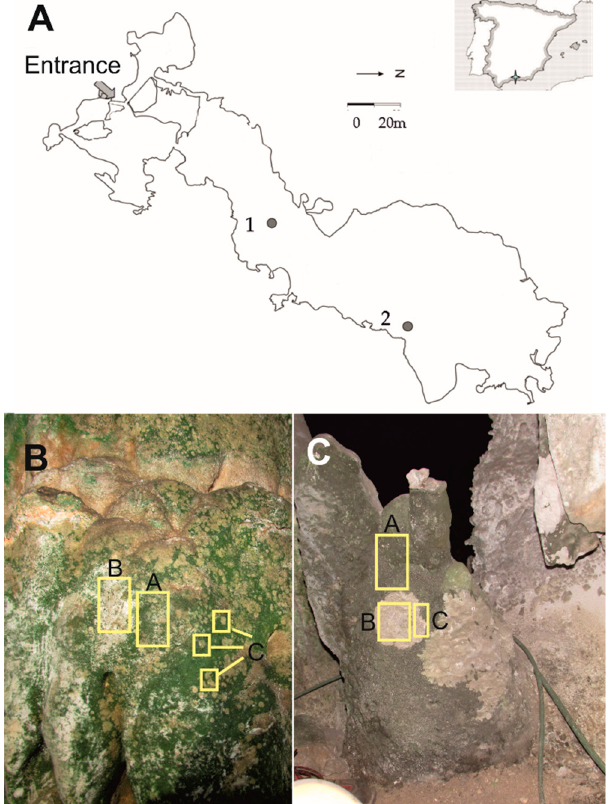
Figure 1. Sampling of biofilms in Nerja Cave speleothems. ( A ) Map of part of the cave and location of the sampling sites. ( B ) Sampling site 1. ( C ) Sampling site 2.